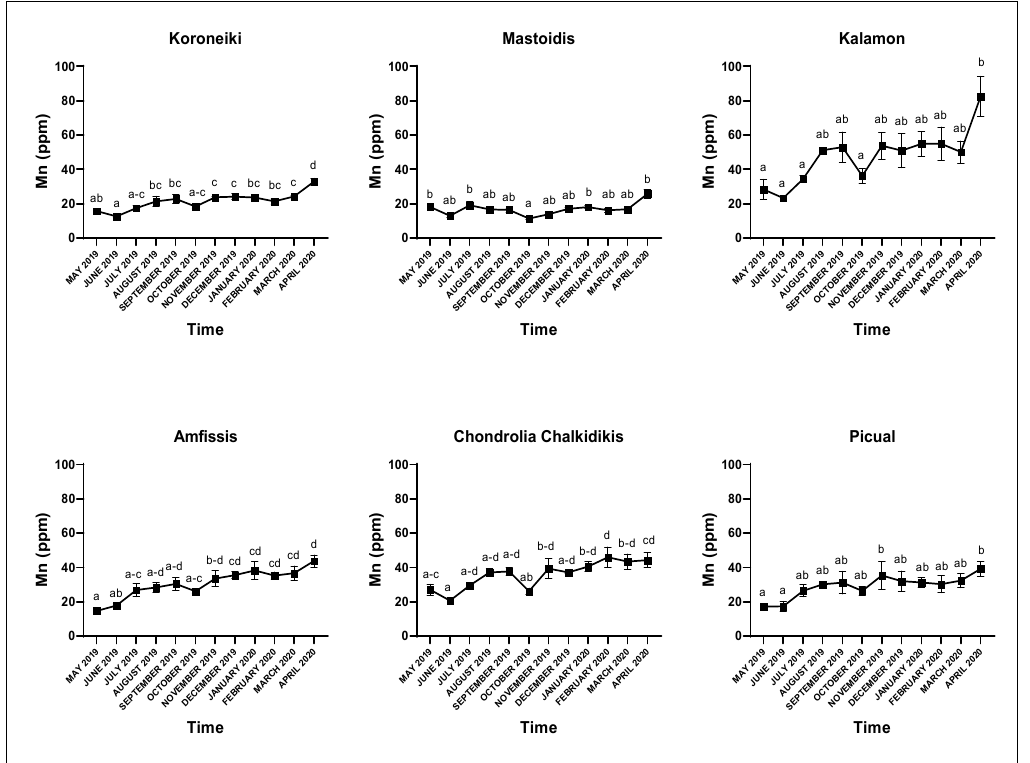
Figure 5. Seasonal trends of manganese concentration in olive leaves developed during annual growth. Error bars represent the standard error of the mean of three replicates. Means within a variety followed by the same letters do not differ at p < 0.05 (LSD